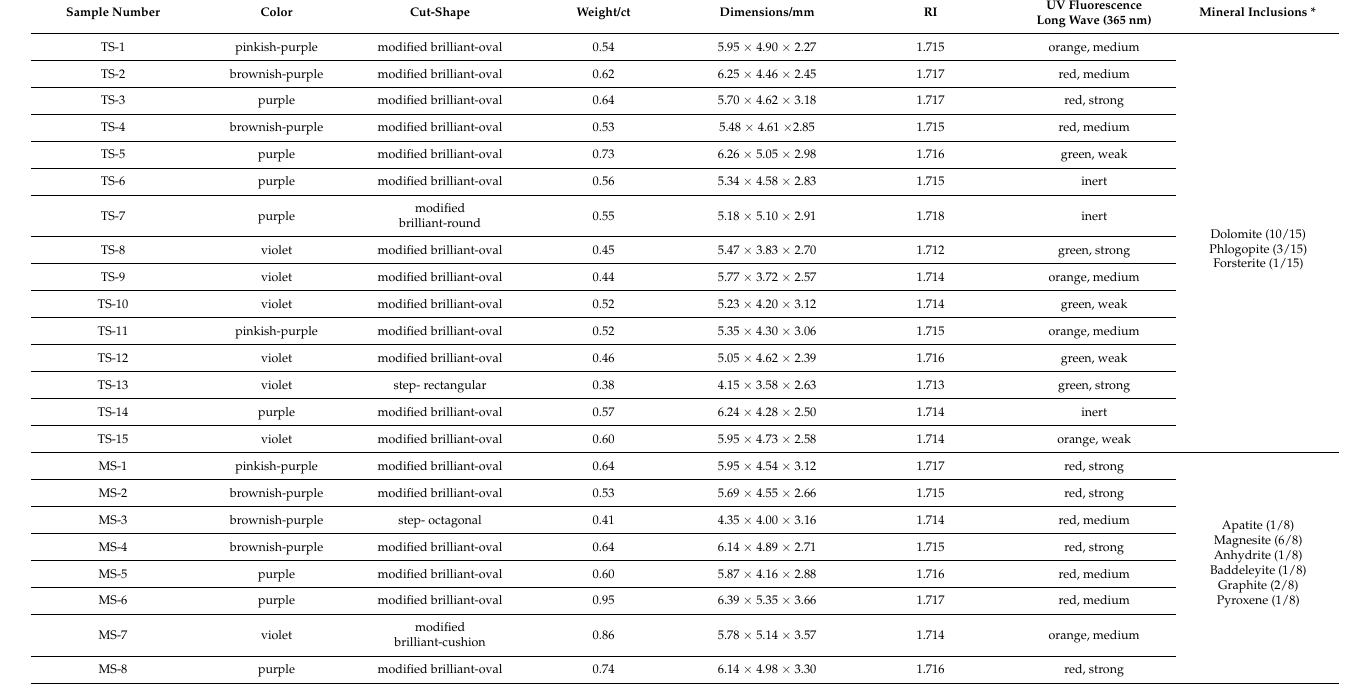
Table 1. Summary of gemological properties of Tanzanian and Myanmar